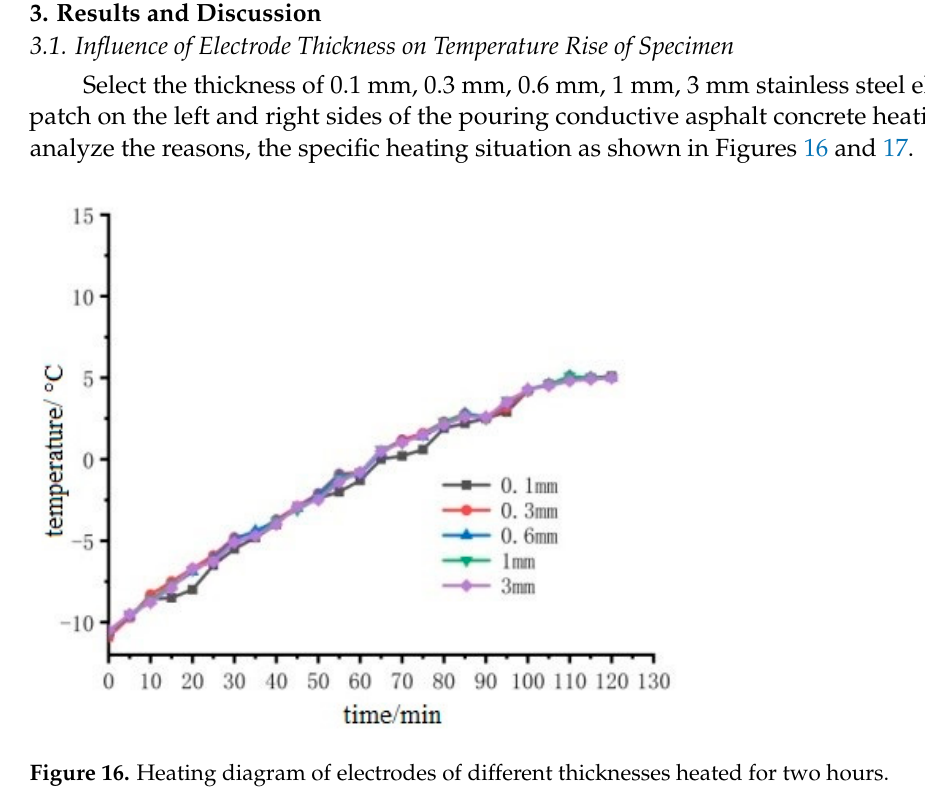
Figure 17. The relationship between electrode thickness and heating rate. It can be seen from Figure 16 that the temperature-time curve of the middle point of the upper surface of the cast-type conductive asphalt concrete with different thicknesses of external electrodes has the same change trend, and the curve almost coincides. The small fluctuation is due to the start of the refrigeration function, when the temperature of the low temperature box is higher than the set value. The airflow and temperature of the